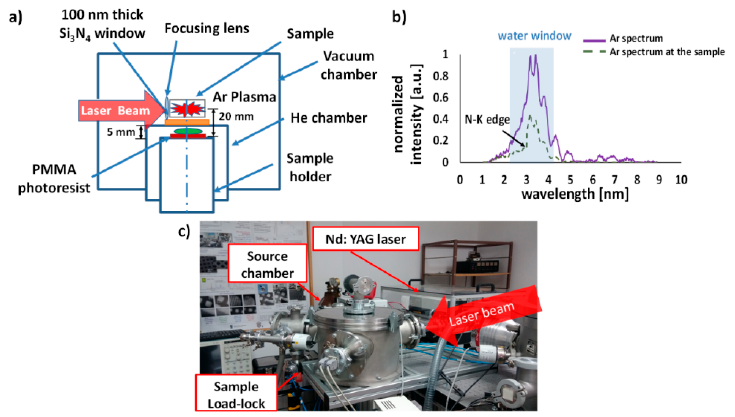
Figure 12. ( a ) Scheme of the SXR contact microscope setup. ( b ) Spectrum of Ar emission acquired directly from the plasma (continue, purple-line) and at the sample plane (dashed-green line). Image modified, based on [86]. ( c ) Picture of the SXR contact microscope system.